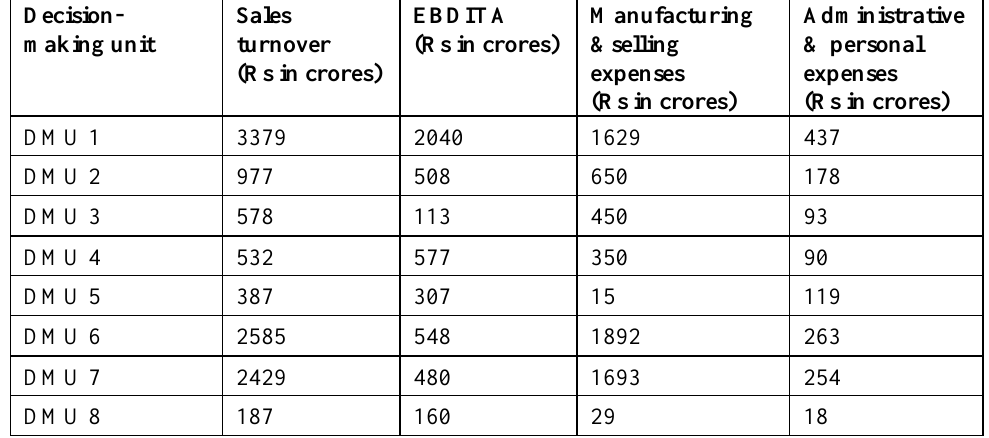
Table 2. Data related to Post-demonetization 2016 – 2018 (The Economic Times,